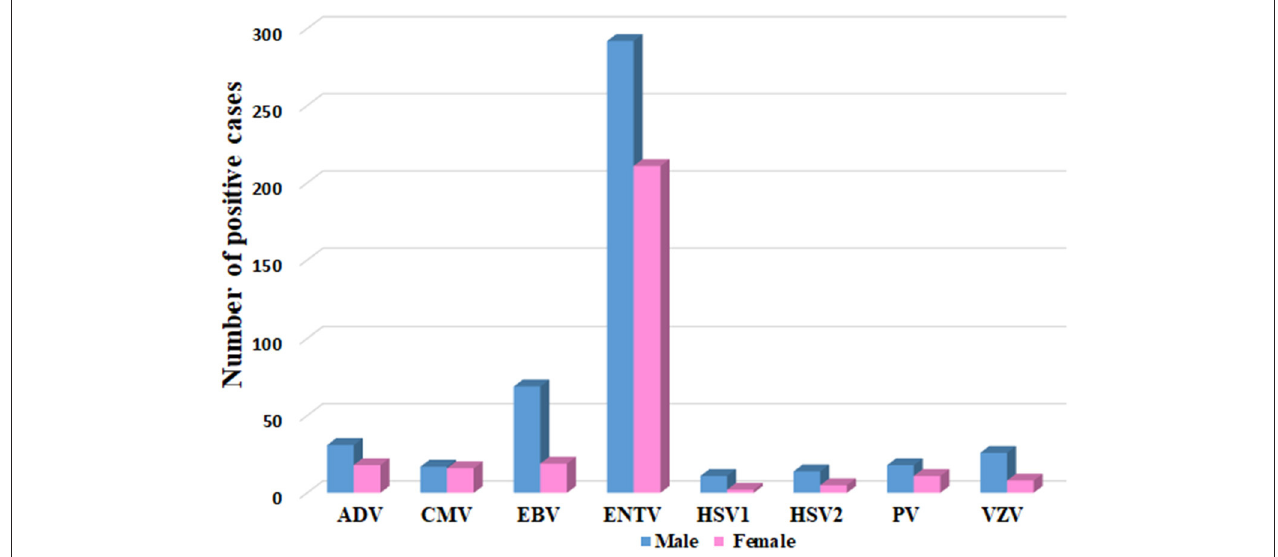
FIGURE 3 | Gender distribution of VM agents, represented as number of positive cases in Y axis and each specific VM virus in Y-axis.